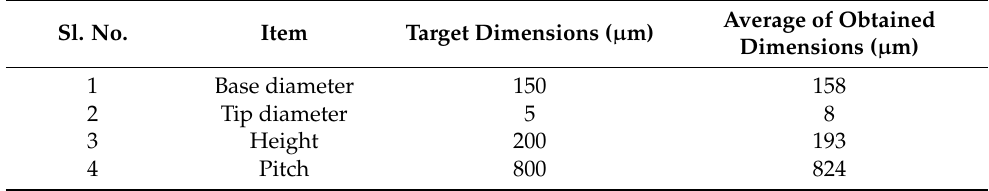
Table 2. Dimensions of microneedles. Sl.